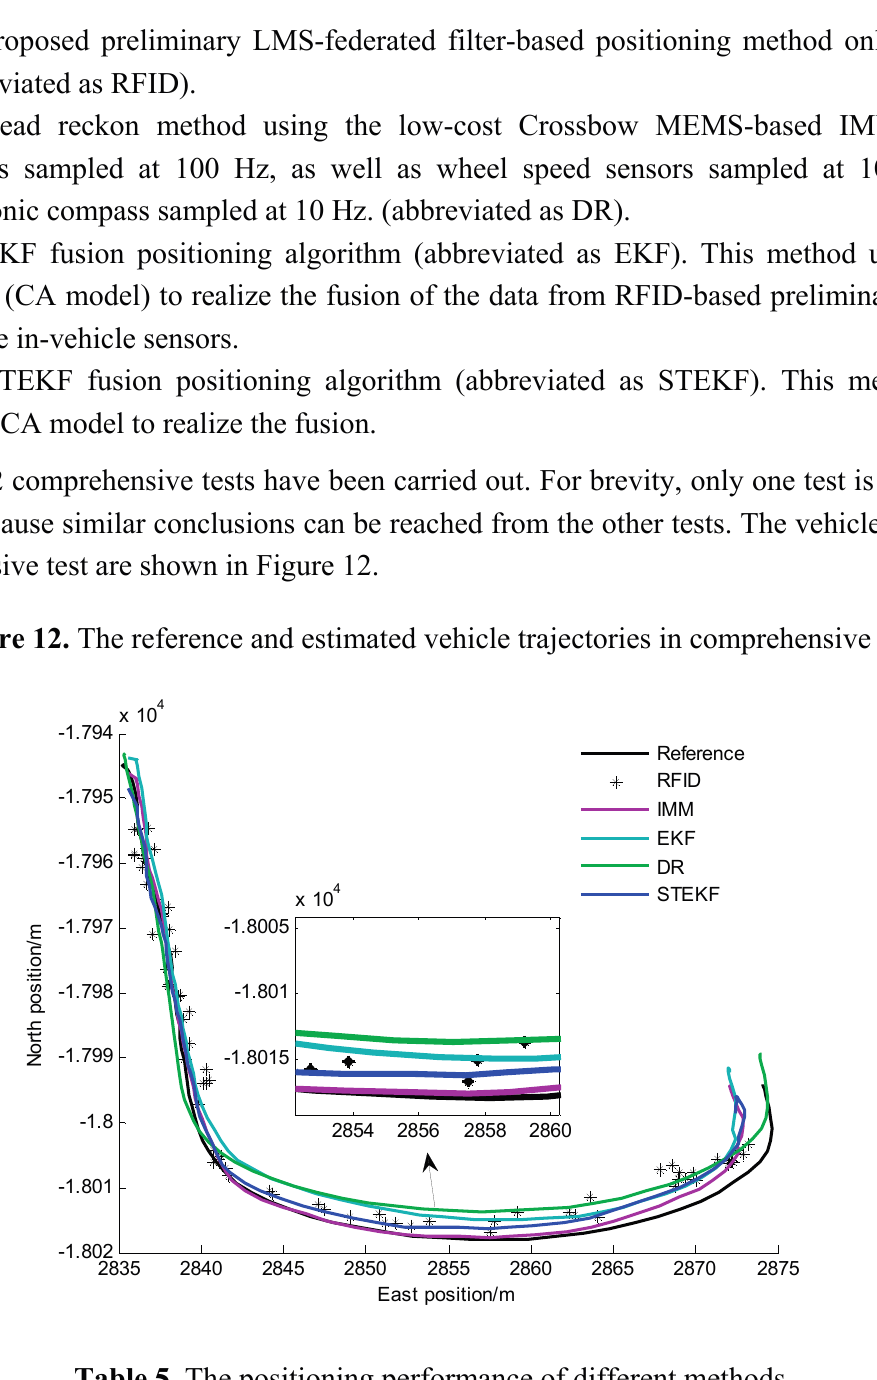
Table 5. The positioning performance of different